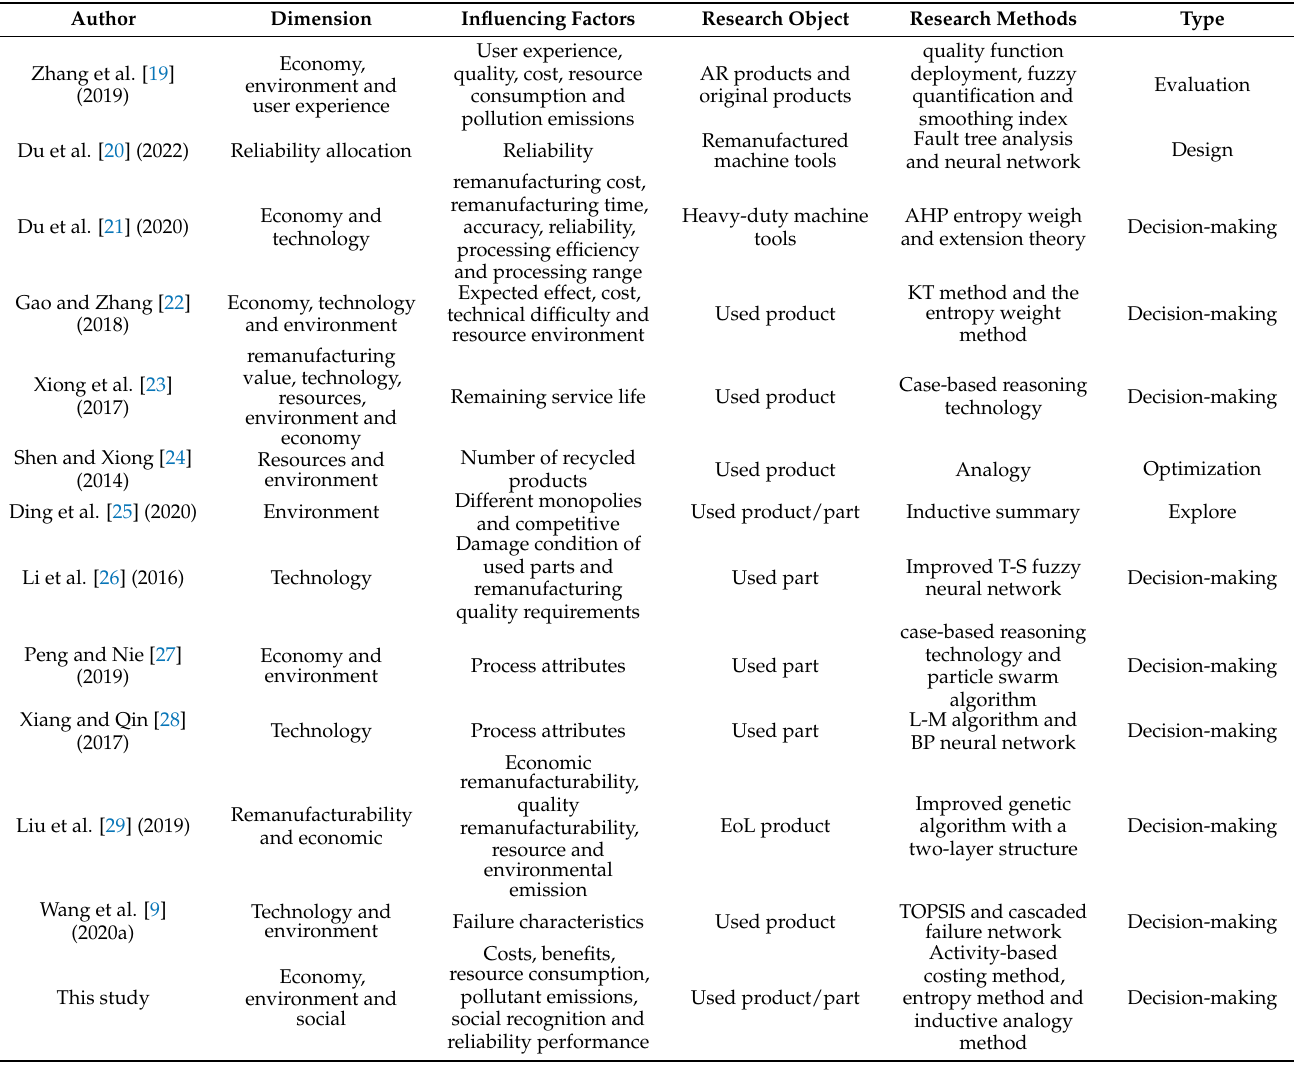
Table 1. Comparison of related